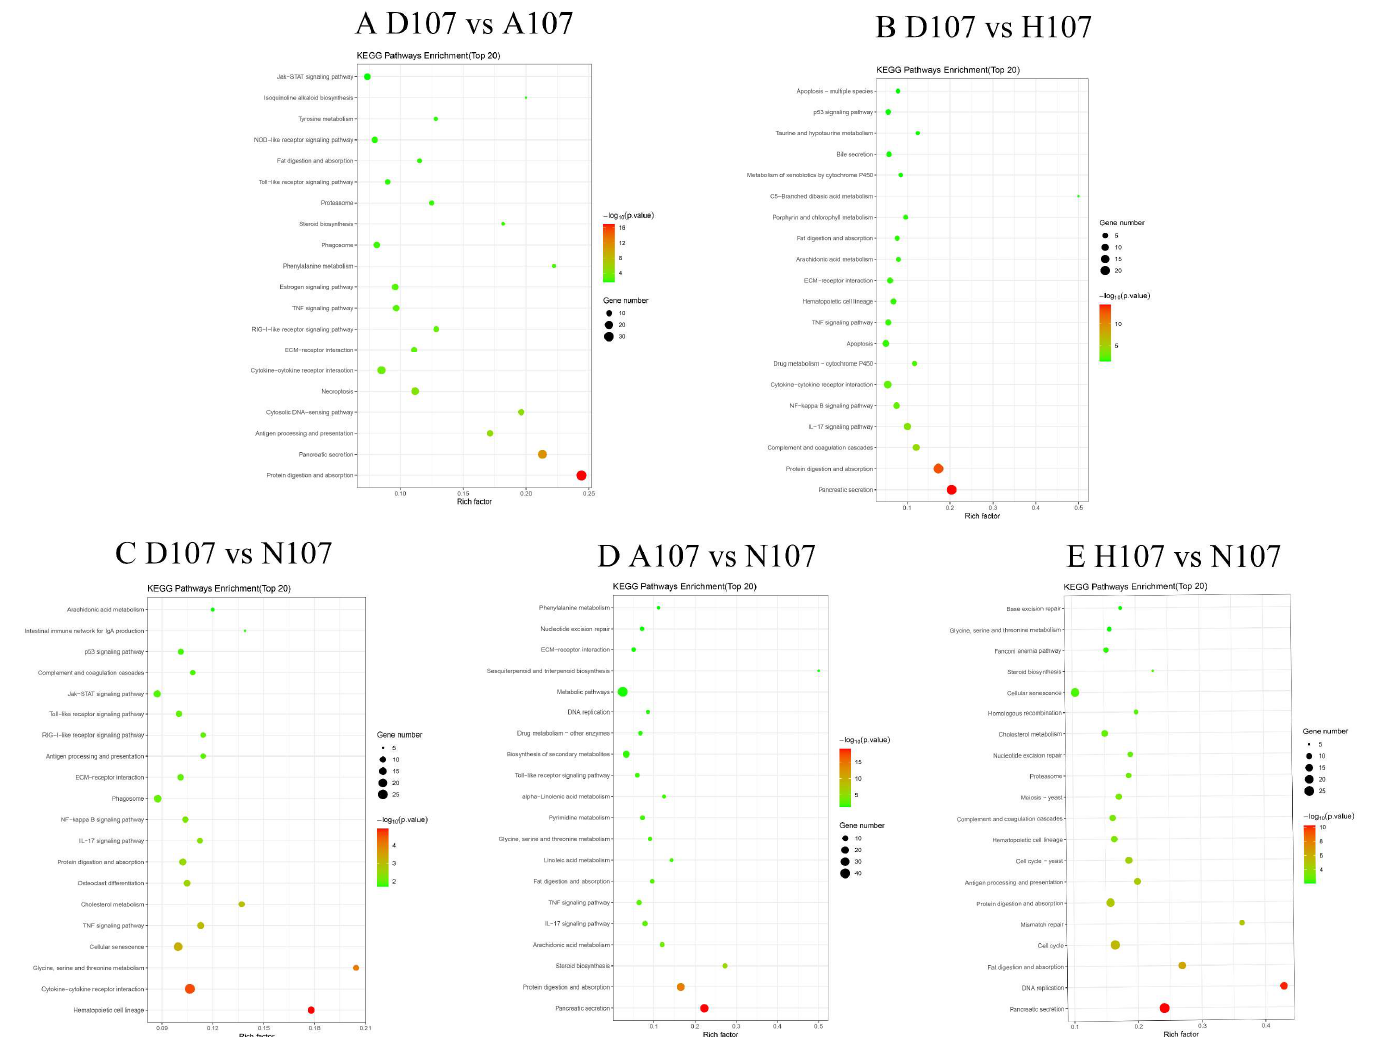
Figure 5. KEGG enrichment analysis of the DEGs under hypoxia and acidification stress.